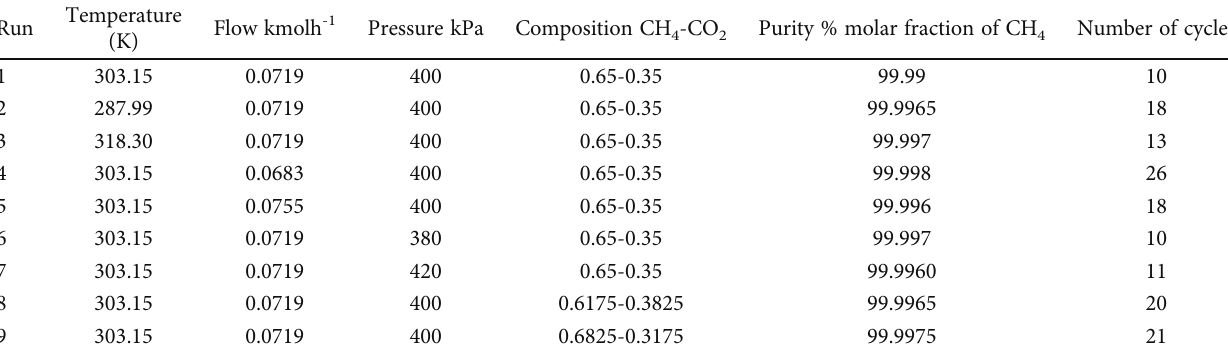
Figure 14: Sensitivity analysis applied to the PSA process for the production of biomethane. Table 25: Analysis of the possible input variables that have the greatest e ff ect on the purity obtained.